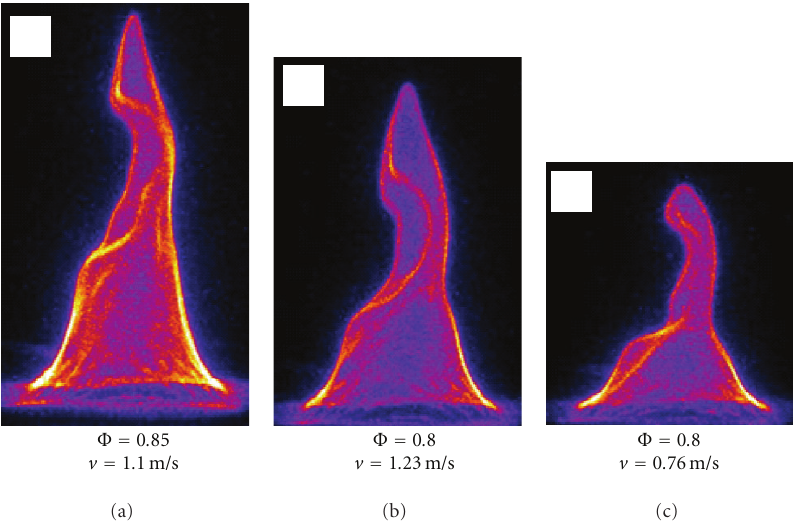
Figure 9: CH (A-X) chemiluminescence showing flow speed-dependent propagation of the flame reaction zone structure modification with pulsed applied voltage. The speed at which the flame flow perturbation moves downstream is dependent on the total flow speed.